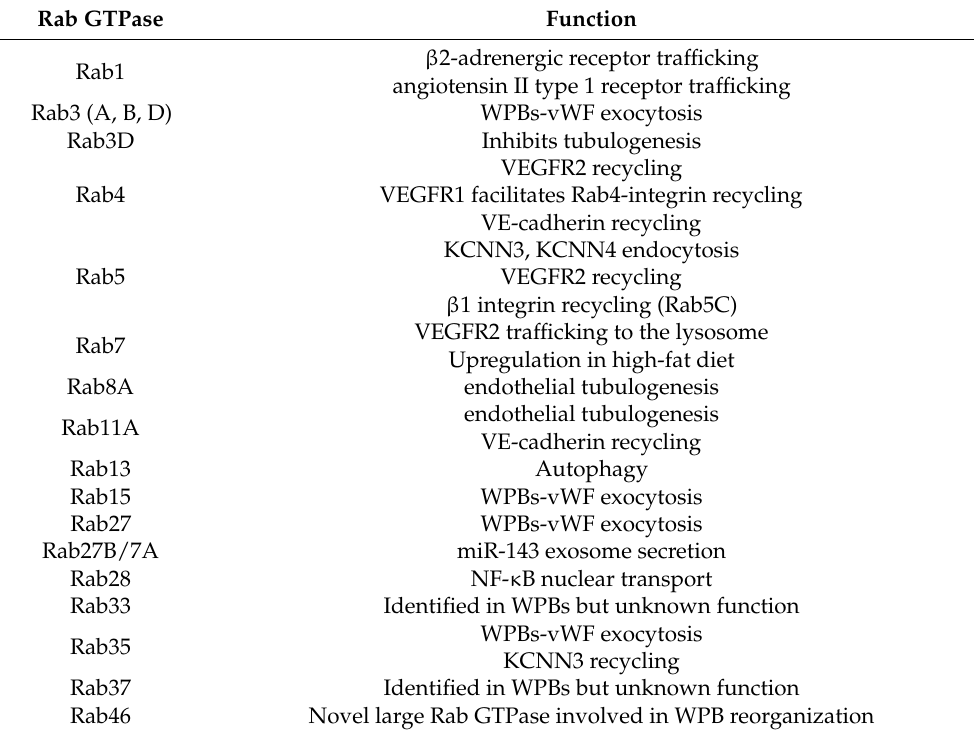
Table 1. Rab GTPases identified in endothelial cells and their